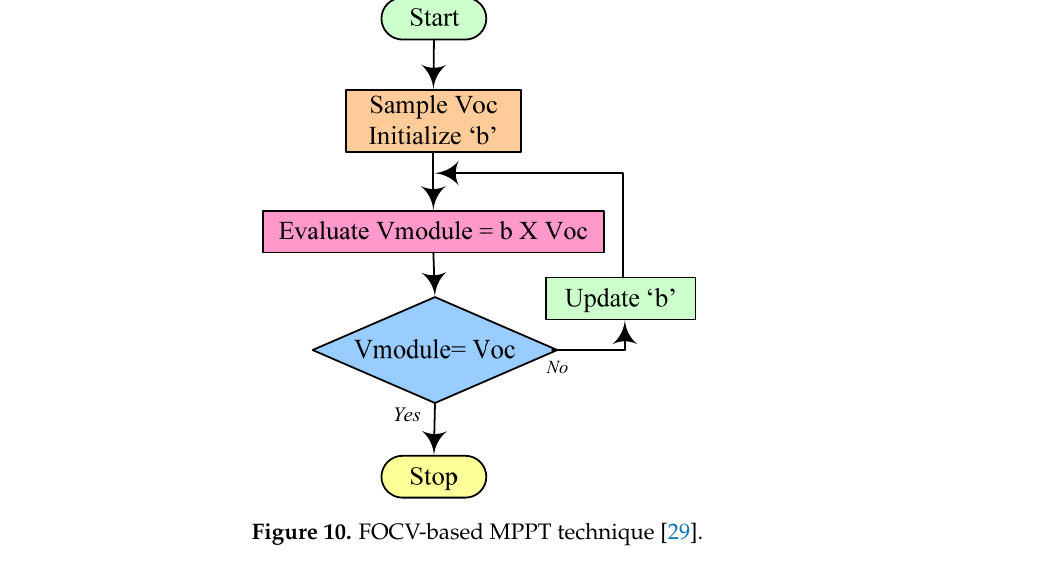
No Figure 9. INC-based MPPT technique [27]. 4.1.3. Fractional Open-Circuit Voltage Technique FOCV MPPT technique is an indirect scheme to track MPP and can be utilized for low-power functions. This technique utilizes the principle that shows linear relationship between V